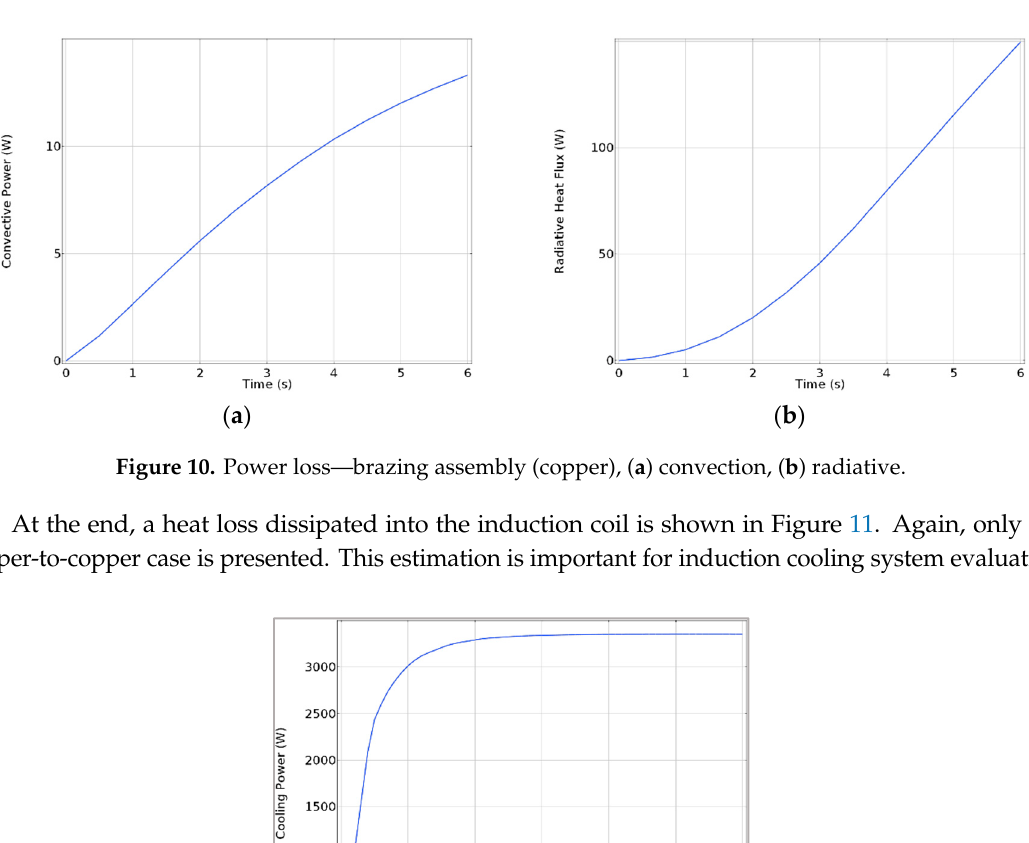
Figure 12. Transformer presentation of the coil and of the workpiece.